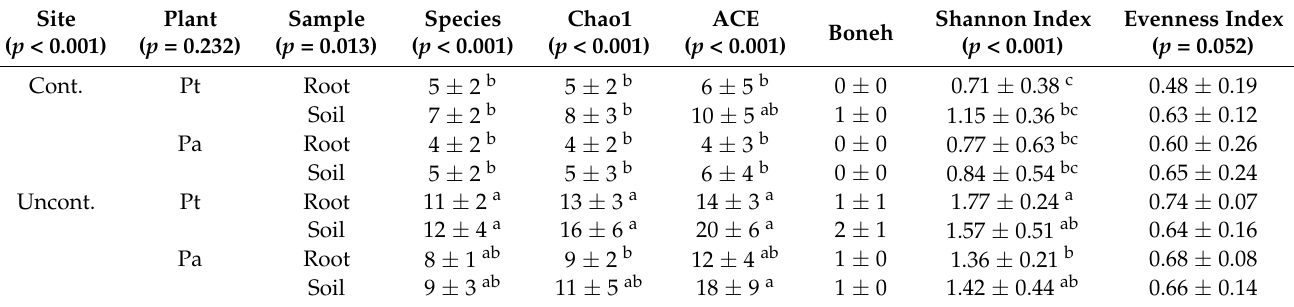
Table 1. The values of α -diversity estimators (mean ± SD) of the roots and soil AMF communities associated with P. trivialis (Pt) and Ph. australis (Pa) collected from the site contaminated with phenol and PAHs and the uncontaminated site. p -values from the permutational analysis of variance (PER- MANOVA) indicate significant differences between the AMF communities associated with different sites, plants, or matrices (roots/soil). p -values from the Kruskal–Wallis test indicate significant differ- ences between the AMF communities for each estimator (species observed, Chao1, ACE, Shannon Index, Evenness Index). Significant post-hoc pairwise Mann–Whitney U comparisons ( p < 0.05) between the communities for each estimator are indicated by different superscript